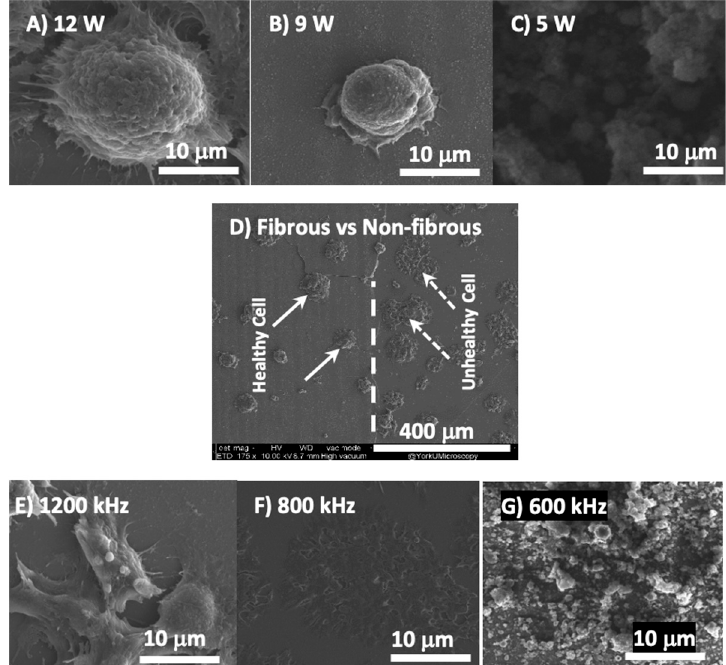
Figure 14. SEM images of cells attached on the surface of samples produced with laser power of ( A ) 12 W; ( B ) 9 W and ( C ) 5 W; ( D ) SEM images of cells attached on the mutual NFTi surface and glass border of samples produced with laser frequency of 1200 kHz. SEM images of cells attached on the surface of samples produced with laser frequency of ( E ) 1200 kHz; ( F ) 800 kHz; and ( G ) 600 kHz.